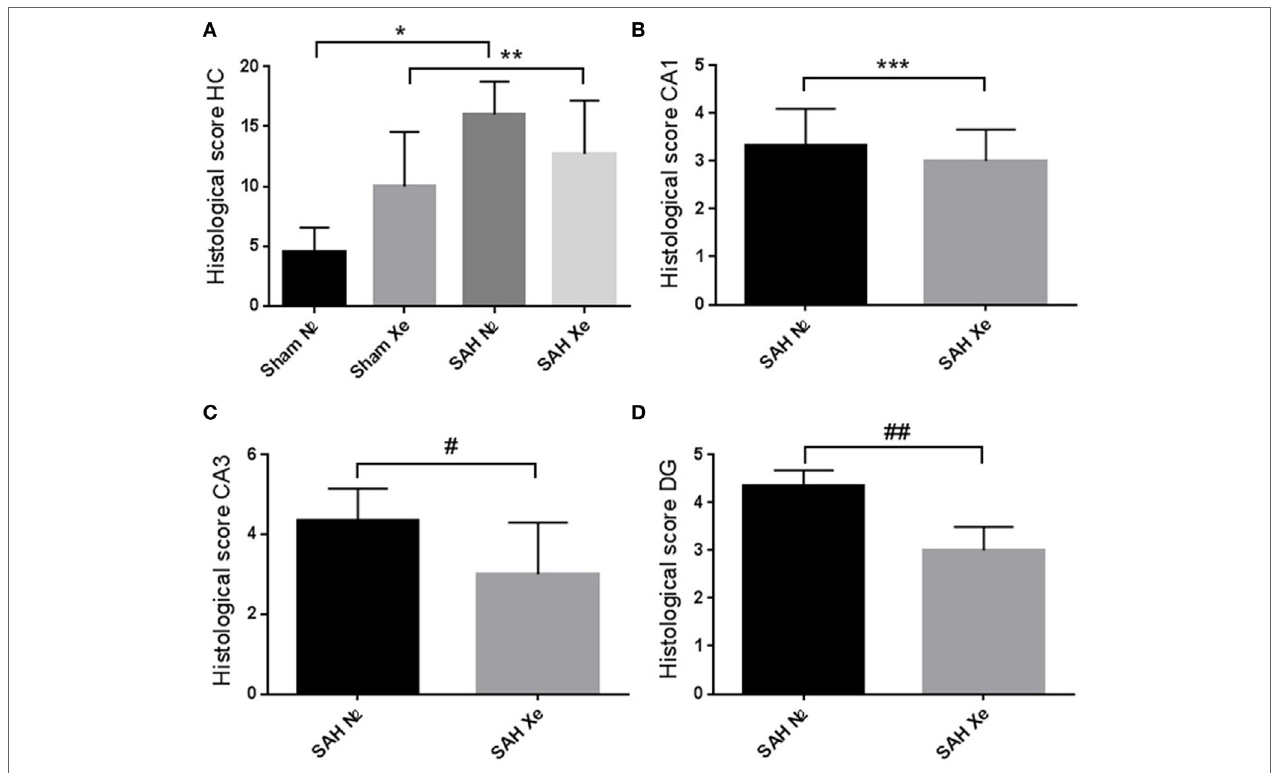
Figure 5 | Hippocampal neuronal cell loss. Cytomorphological quantification of ischemic damage. (A) After summing up the four scores (0–5) per hippocampal region, a single score per animal between 0 and 20 was yielded. The summed-up scores were 4.5 ± 1.83 (Sham N 2 ), 10 ± 4.05 (Sham Xe), 16 ± 2.52 (SAH N 2 ), and 12.71 ± 4.13 (SAH Xe) group. There was no difference between the SAH N 2 and SAH Xe groups. There was a significant difference between the Sham N 2 and SAH N 2 groups, *p = 0.0001. There was no significant difference between Sham Xe and SAH N 2 groups, **p = 0.326. (B) The CA1 region of the SAH N 2 group and the SAH Xe group had a mean histopathological severity score of 3.33 ± 1.70 vs. 3.0 ± 1.60, ***p = 0.4280. (C) In the CA3 regions, a significant difference group-score was seen, 4.5 ± 0.76 (SAH N 2 ) vs. 2.71 ± 1.58 (SAH Xe) group, #p = 0.040. (D) The difference was also statistically significant in the DG regions 4.24 ± 1.38 vs. 3.09 ± 1.28, ##p =